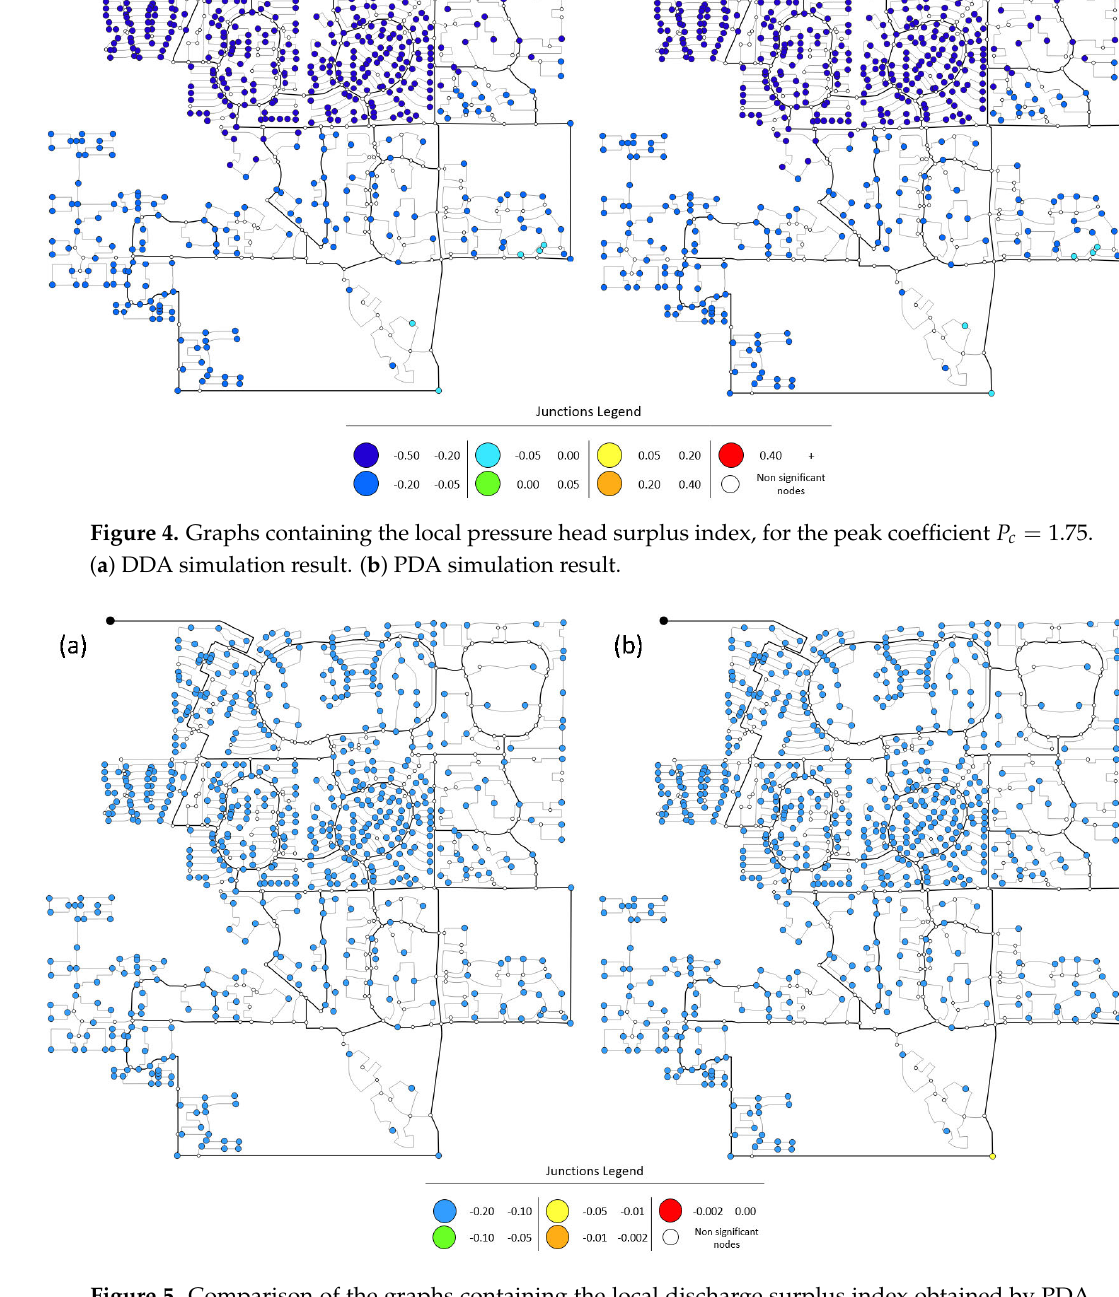
Figure 5. Comparison of the graphs containing the local discharge surplus index obtained by PDA simulation for different peak coefficients. ( a ) P c = 1.75. ( b ) P c =